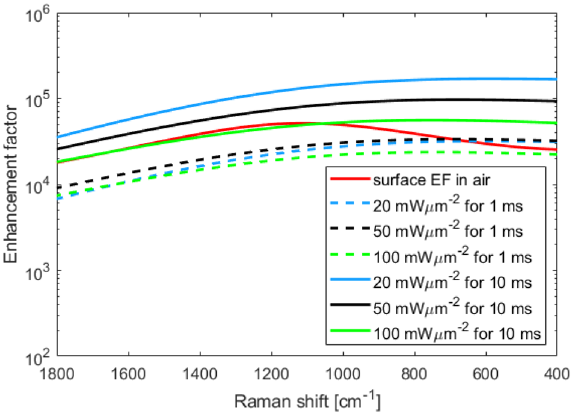
Figure 5. Calculated enhancement factors after 1 ms (dashed lines) and 10 ms (solid lines) of an incident plane wave (wavelength 785 nm) with intensity 20, 50 and 100 mW μm − enhancement factor in air ( cf. Fig. 3b) (solid red line) is shown for comparison.